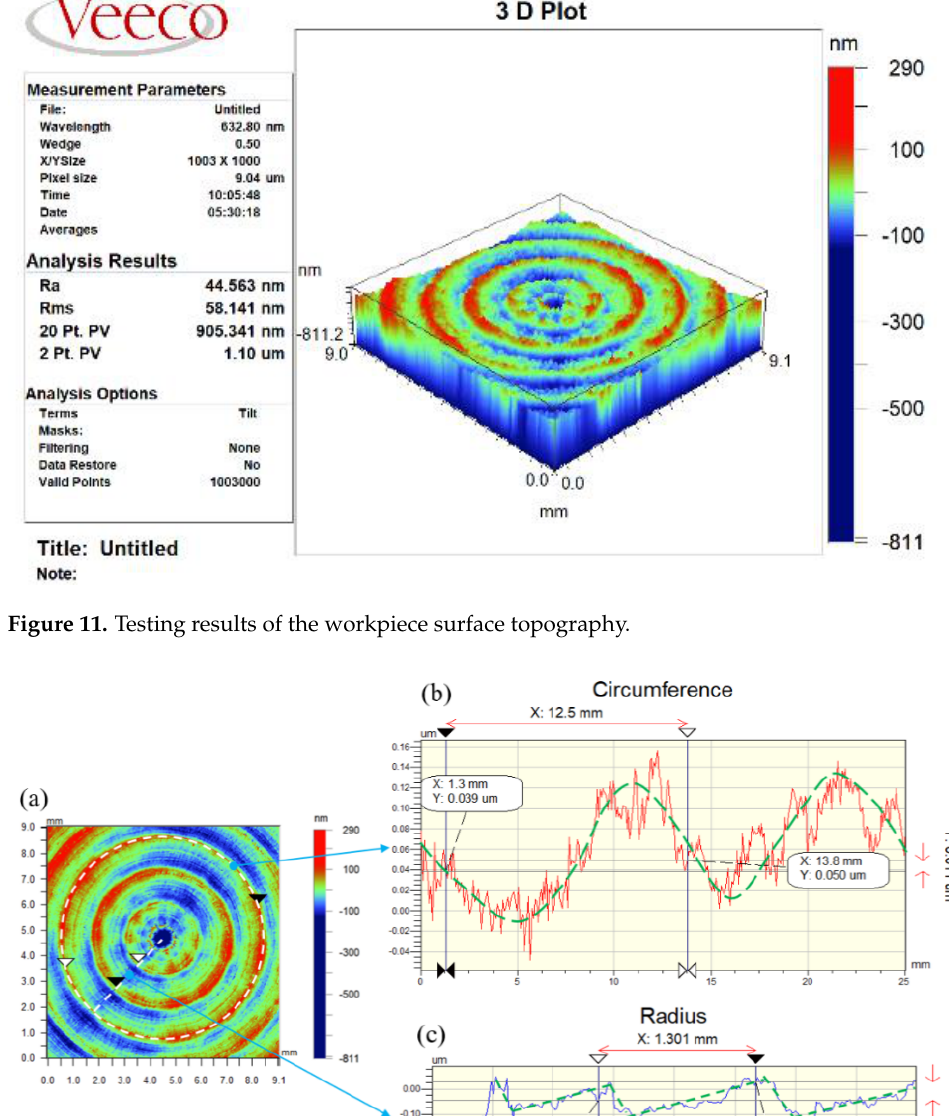
Figure 11. Testing results of the workpiece surface topography.